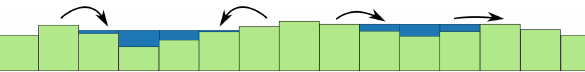
Figure 1. Filled depressions allow runoff to pass over them, while unfilled depressions act as sinks to flow. The green blocks indicate the topographic surface with variable elevation, and the blue indi- cates the final water depth after running FlowFill. The lake on the left is not completely filled, and its level is therefore lower than the height of cells on either side. Water would continue to flow into this depression from all directions. On the right, water has completely filled a depression. Any flow entering this area from the left is able to flow out on the right and continue